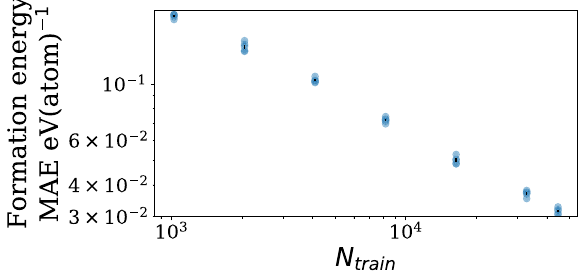
Fig. 4 Learning curve for JARVIS-DFT formation energy regres- sion target. Blue markers indicate validation set MAE scores for individual cross-validation iterates. Error bars indicate the mean cross-validation MAE ± one standard error of the